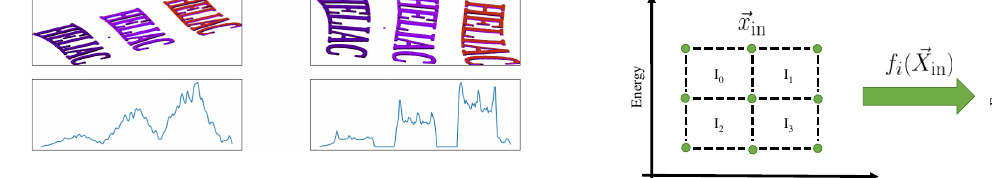
FIG. 3. The input distribution beam line by f i ð